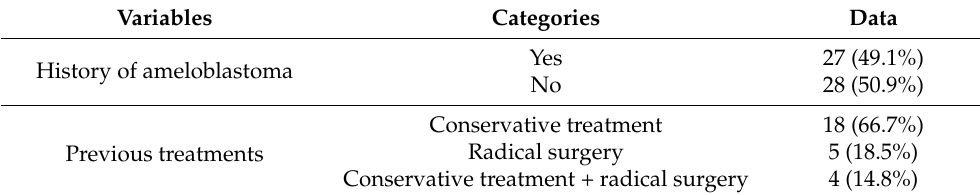
Table 2. Previous treatments in patients with ameloblastoma